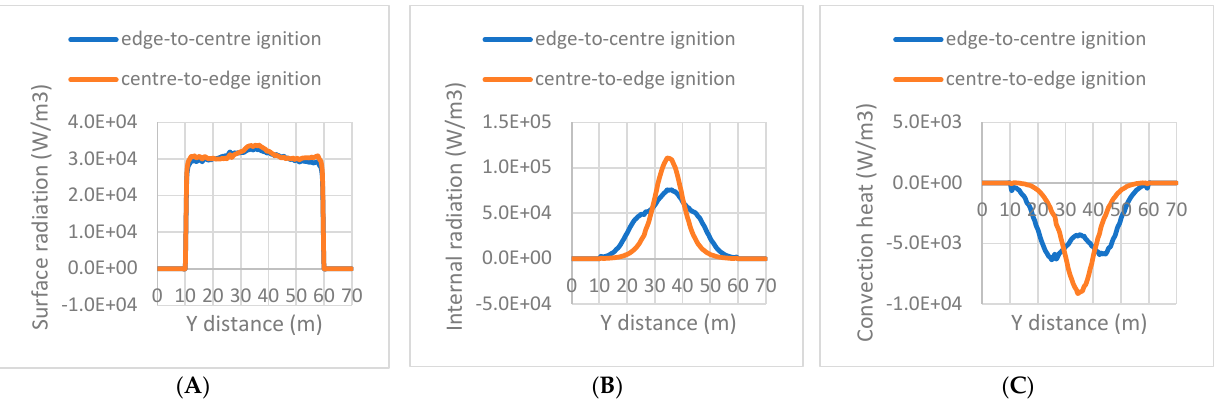
Figure 7. Fire contours and streamlines at mid-height of the fuel layer 20 s after the fire started. The fire contour is located at temperatures above 500 K.